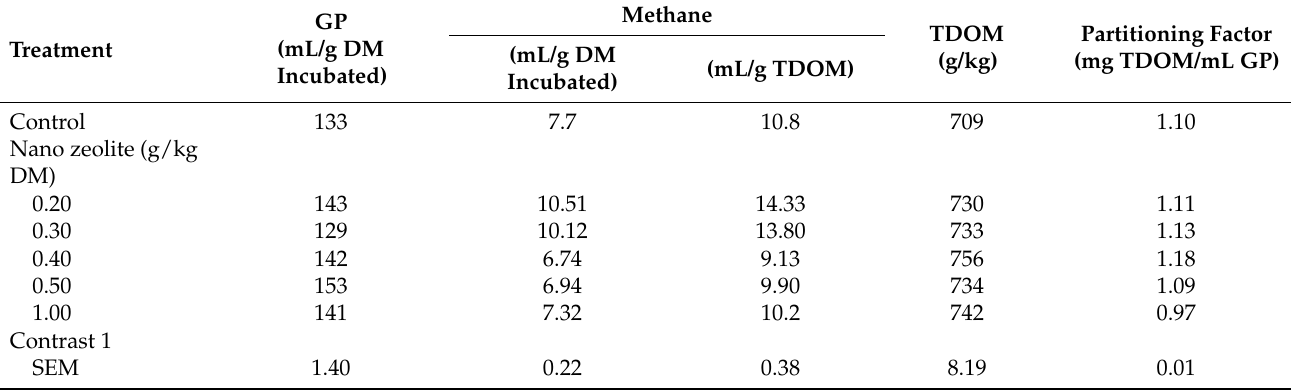
Table 3. Supplementation effects of natural and nano-zeolite forms on ruminal gas production (GP), methane, truly degraded organic matter (TDOM), and partitioning factor through 24 h incubation period ( in vitro experiment).